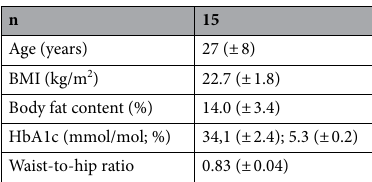
Table 3. Subject characteristics. Values are given as mean ± SD.